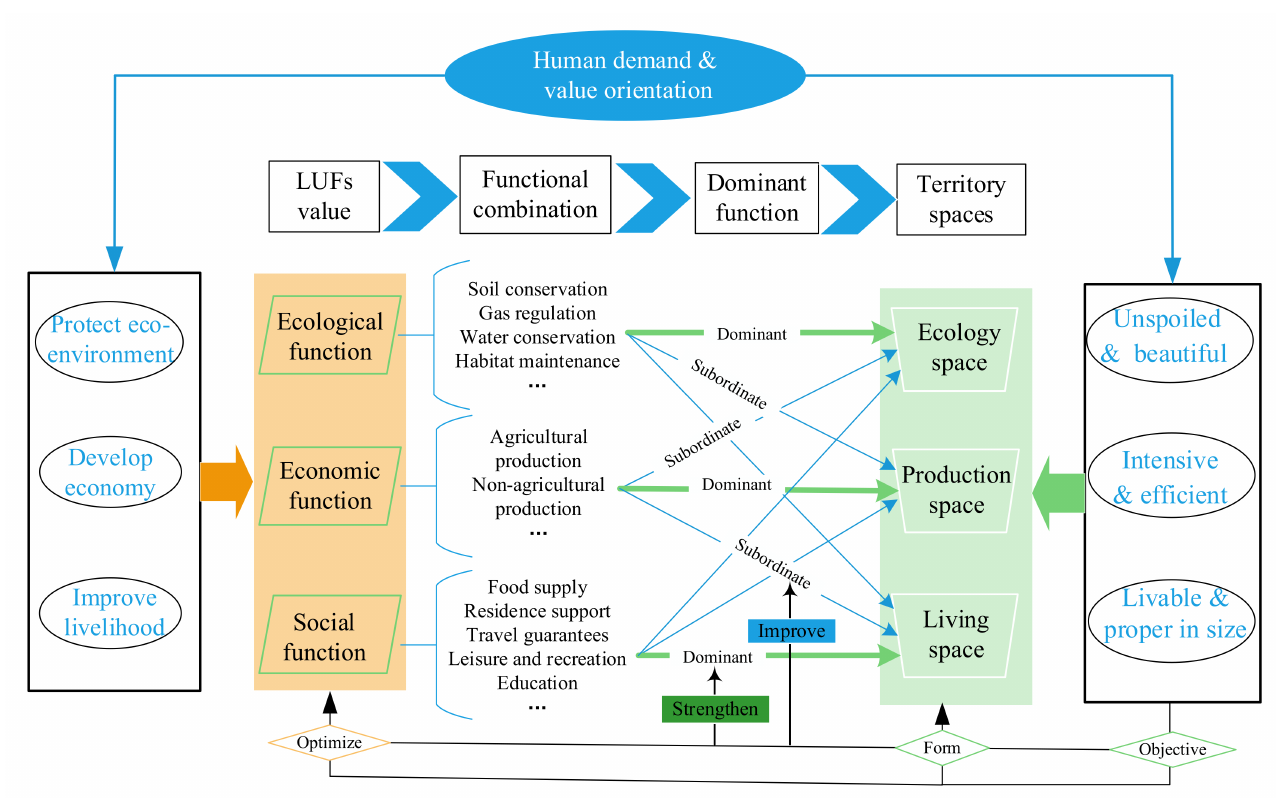
Figure 8. The conceptual framework of optimization of ecological–living–production space based on LUFs’